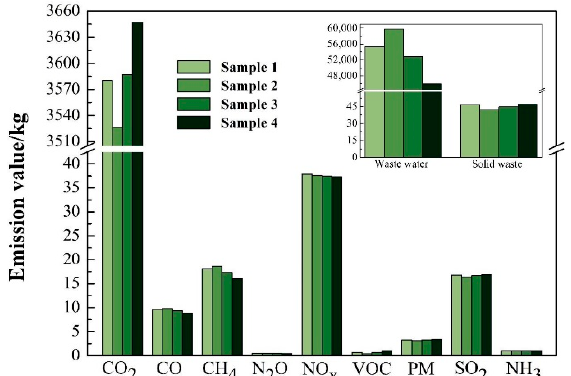
Figure 3. Waste emitted from one ton of the PLA-based WPCs.